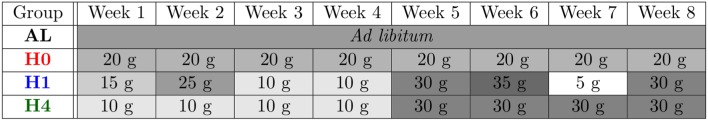
Daily available food per rat in each group.Changes of quantities occur each week, except for group AL which was not submitted to caloric restriction. At the end of the 8-weeks experiment, each rat in groups H0, H1 and H4 will have received 1120 g of food. Consumed food is not always equal to this amount but is recorded every day.